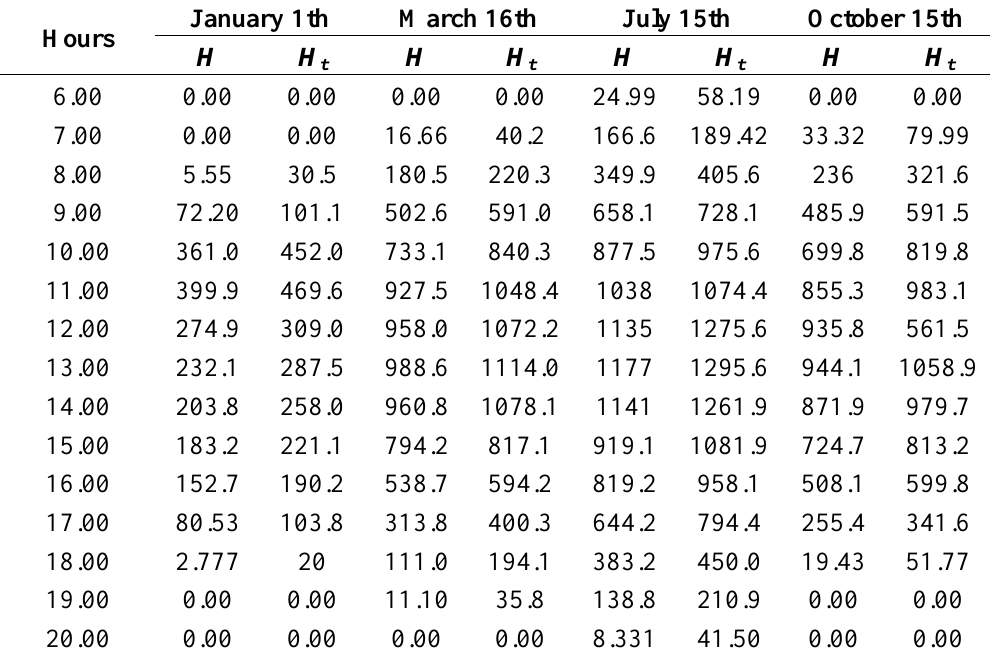
Table 5. Measured global irradiation on an inclined and horizontal surface by W/m 2 for